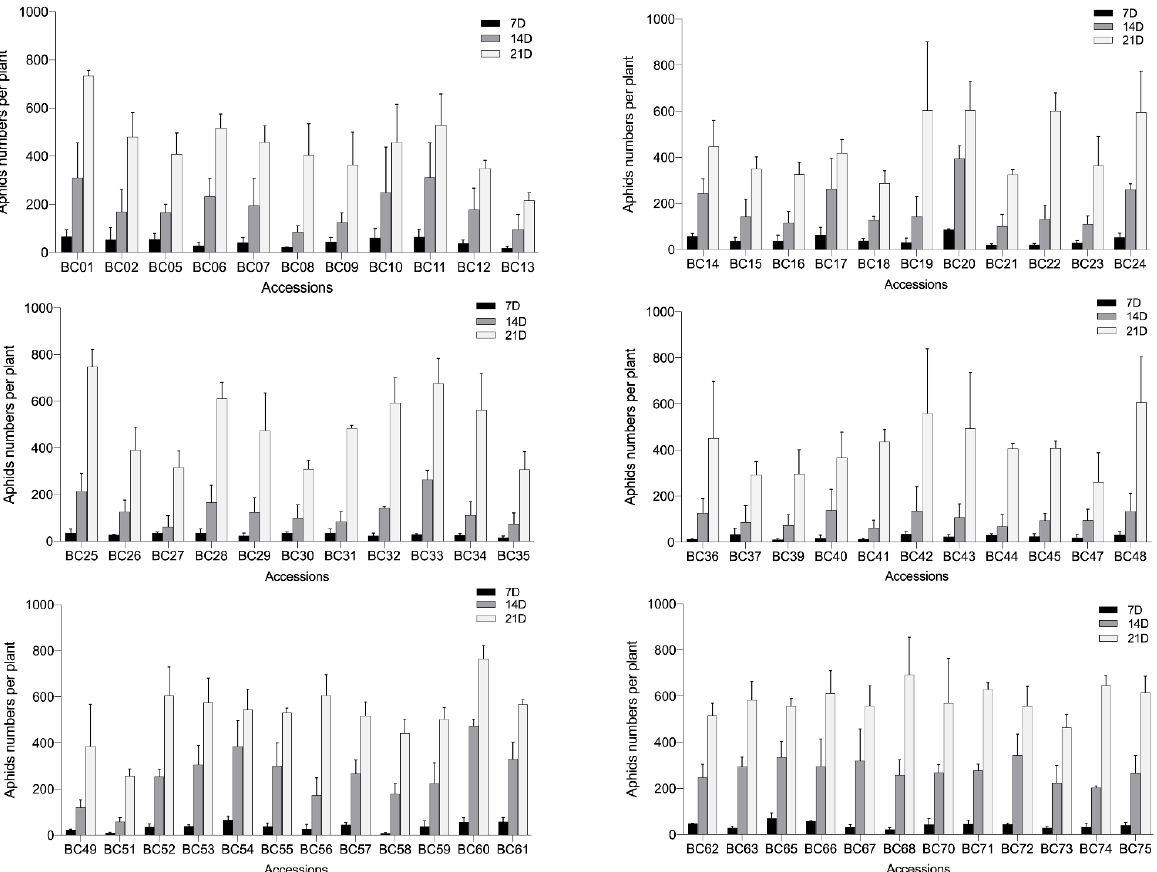
Figure 2. Variations in aphid numbers among the 75 Ethiopian mustard accessions at 7, 14, and 21 days after infestation. Bars represent the means ±